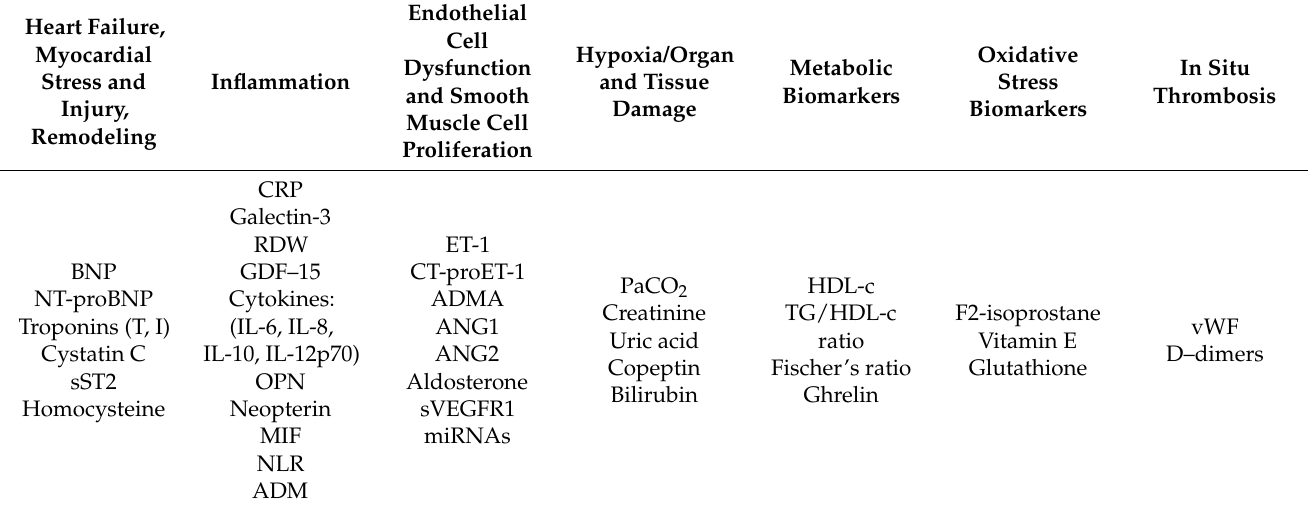
Table 1. Circulating Biomarkers in